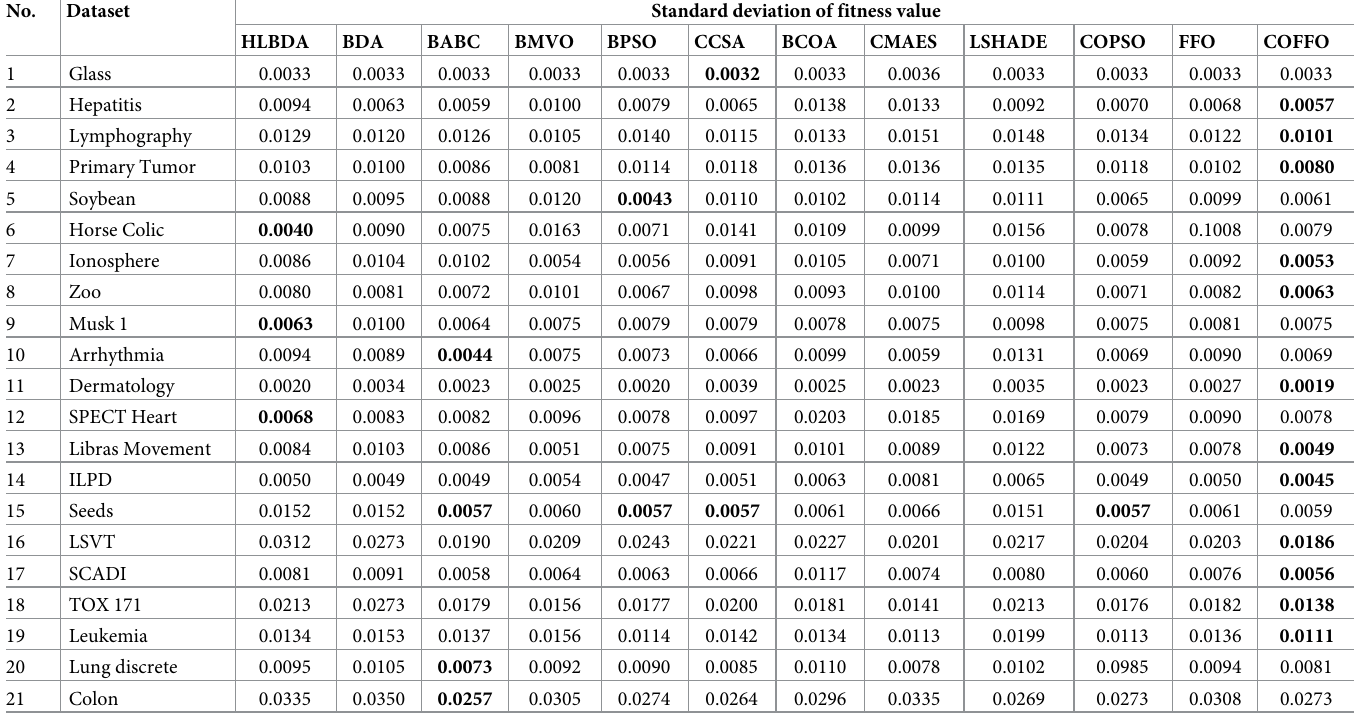
Table 11. Standard deviation of fitness value results for tested algorithms.